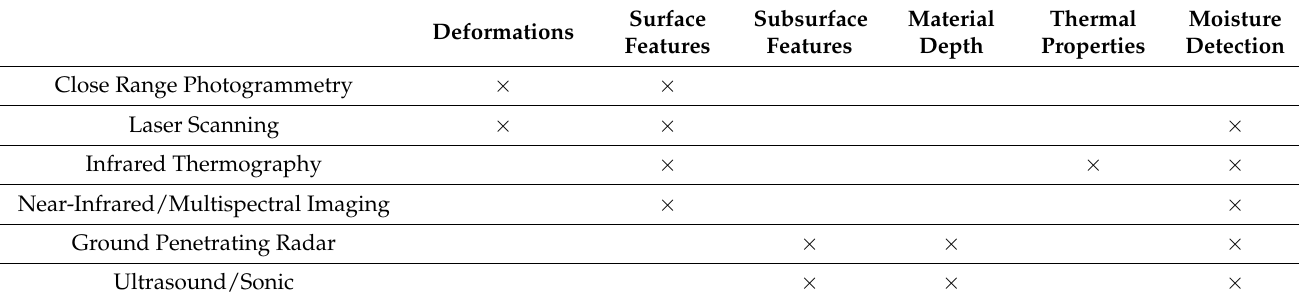
Table 4. Characteristics of close-range sensing techniques for built heritage applications.